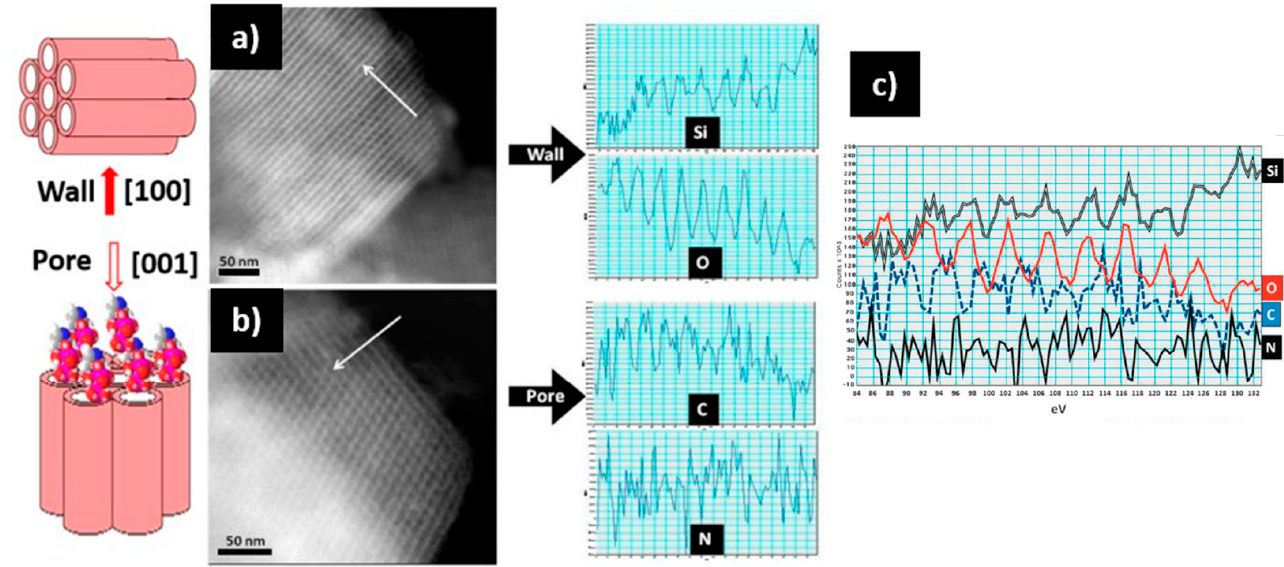
Figure 9. STEM-HAADF images of SBA-15 mesoporous matrix loaded with zolendronate molecules along the wall [100], and the pore [001] and the corresponding EELS intensity profiles (see arrows): ( a ) along [100] the EELS profile shows the presence of Si and O; ( b ) along [001] the pores are observed and the profile reveals the presence of N and C inside; ( c ) along the same direction [001], showing the Si, O, C, and N profiles [84]. Adapted with permission from [84]. Copyright 2010 Royal Society of Chemistry (London, UK).